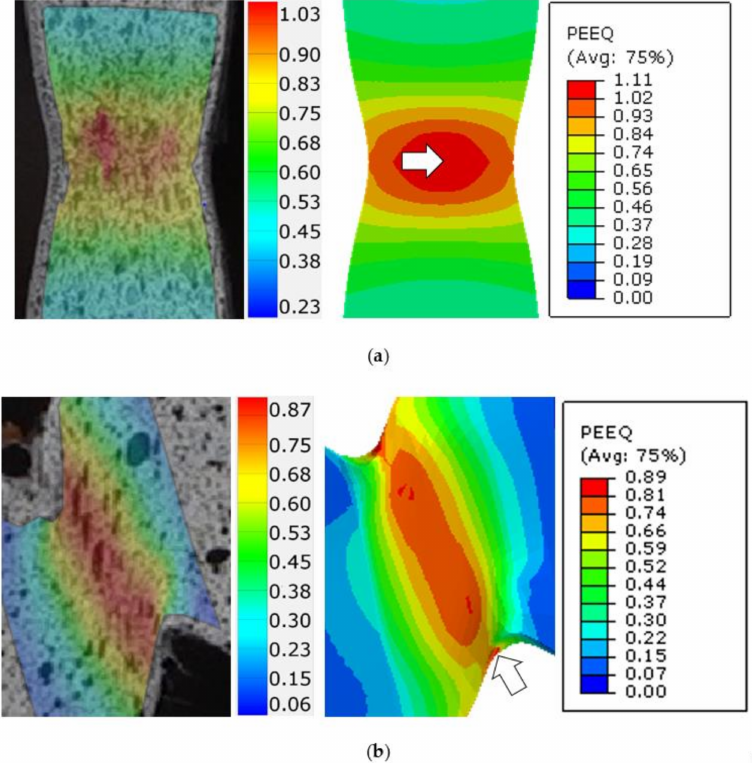
Figure 6. Strain contours obtained from DIC calculation and FE analysis: ( a ) Uniaxial tension specimen; ( b ) In-plane shear specimen.